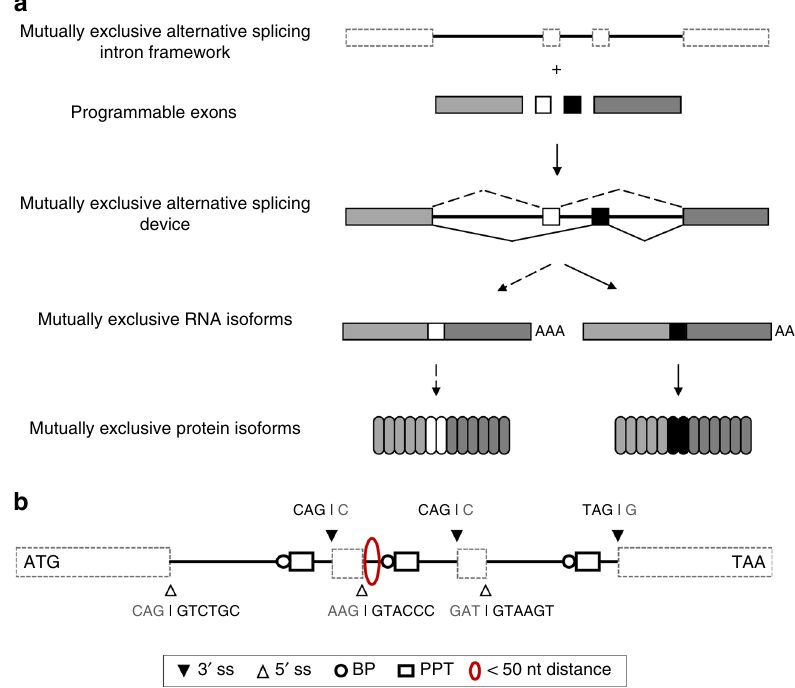
Fig. 1 Overview of the MEAS intron framework. a The intron framework contains three introns that support MEAS events. Incorporation of four programmable and modular exons into the intron framework forms a MEAS device. The device produces at least two mutually exclusive RNA isoforms as a result of splicing, and these RNA sequences are translated into distinct protein isoforms. b Speci fi c features of the intron framework enabling MEAS include: (i) 3 ′ ss (black triangles with native sequences noted above the triangles) and 5 ′ ss (white triangles with native sequences noted below the triangles) sequences de fi ne exon – intron junctions, (ii) BP sequences (white circles) and PPT sequences (white rectangles) facilitate splicing, and (iii) a proximal exon 2 5 ′ ss and exon 3 BP sequence separated by less than 50 nucleotides (red ellipse) prevents spliceosome assembly in order to enforce mutually exclusive behavior. The intron framework encodes one open reading frame with the illustrated start and stop